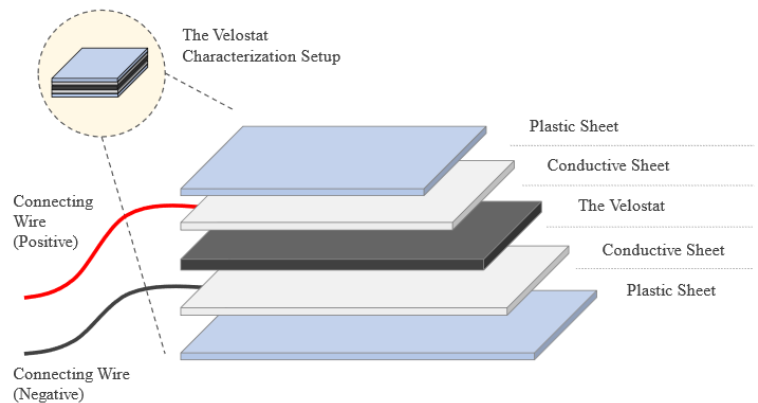
Figure 3. Characterization setup of the Velostat Sheet.